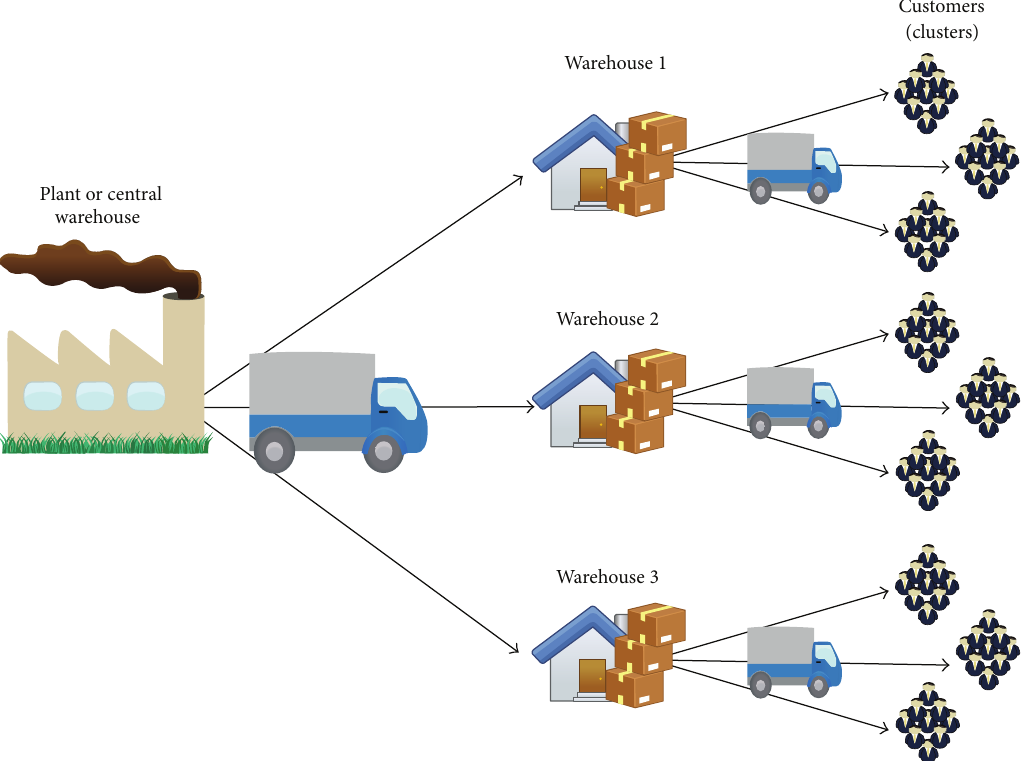
Figure 2: A two-level supply chain network